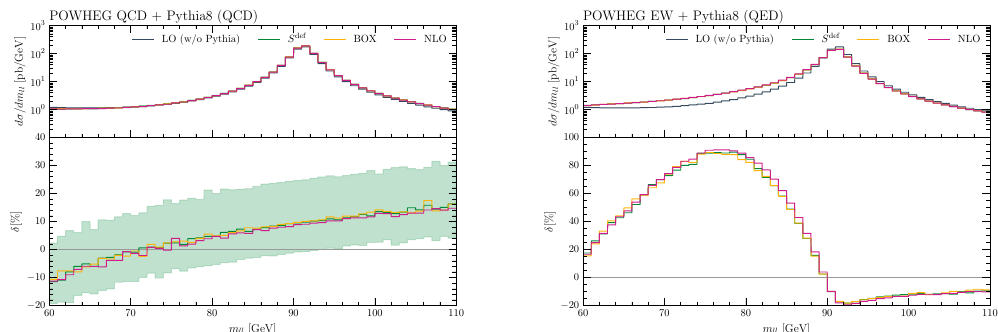
Figure 1 : Invariant-mass distribution of the lepton pair. The LO result is shown along with only the QCD (left plot) and only the EW (right plot) corrections. The results of our implementation of the Powheg method without resonance improvement (labeled by S def ) are compared to the Powheg-Box results (labeled by BOX) and the (cid:12)xed-order NLO results. The lower plots show the relative QCD/QED corrections, where we include a scale-variation error band for the QCD